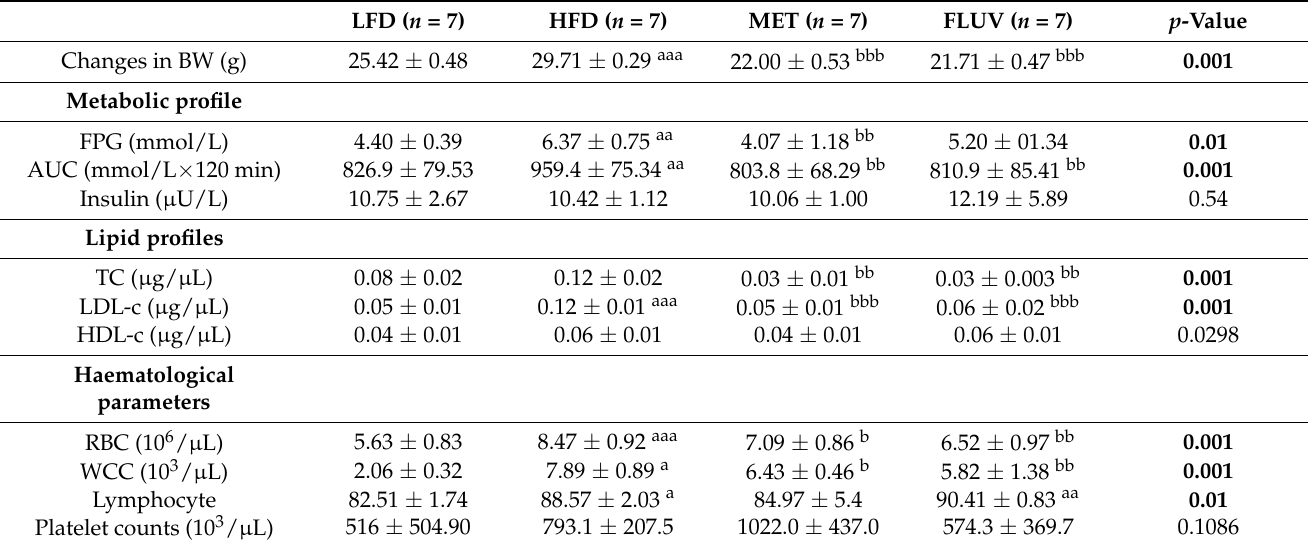
Table 1. Metabolic changes and glucose tolerance following treatments with metformin and